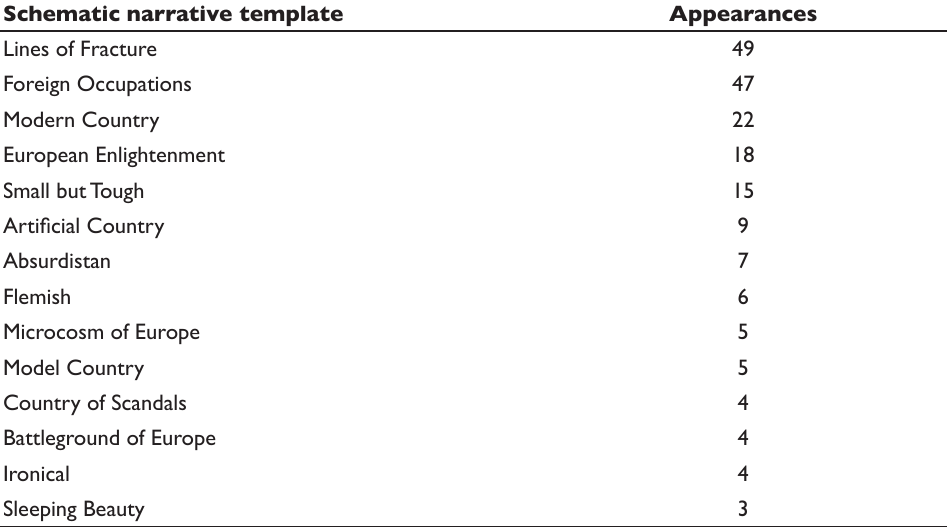
Table 2: FrequencyofappearancesofexistingschematicnarrativetemplatesonBelgianhistory Schematic narrative